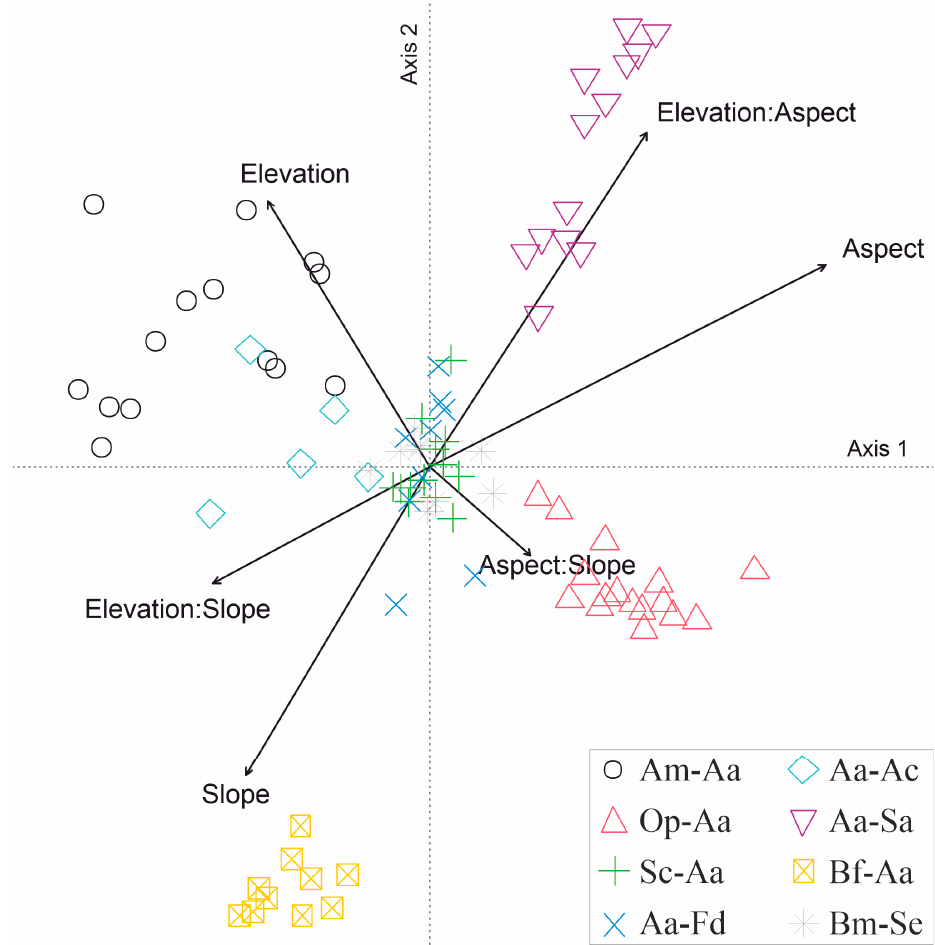
Figure 4. Partitioning of variance in compositional dissimilarity between the 89 studied communi- ties explained by variation in elevation, slope, aspect and di ff erences in the regional species pool.